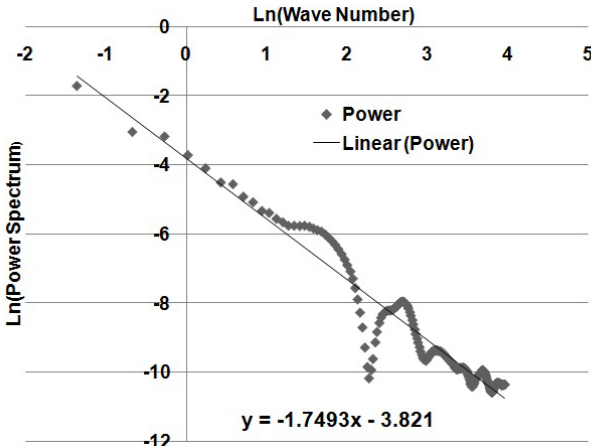
Fig. 1. Log-log plot of power spectrum of heat production data vs. wave number for the Dharwar craton of south Indian shield. Suitable linear equation was fit to the data to obtain the scaling exponent which is 1.7, indicating fractal behavior in the data set. Linear fit indicates strong correlation between the adjacent points and substantiate power law regime in the data.